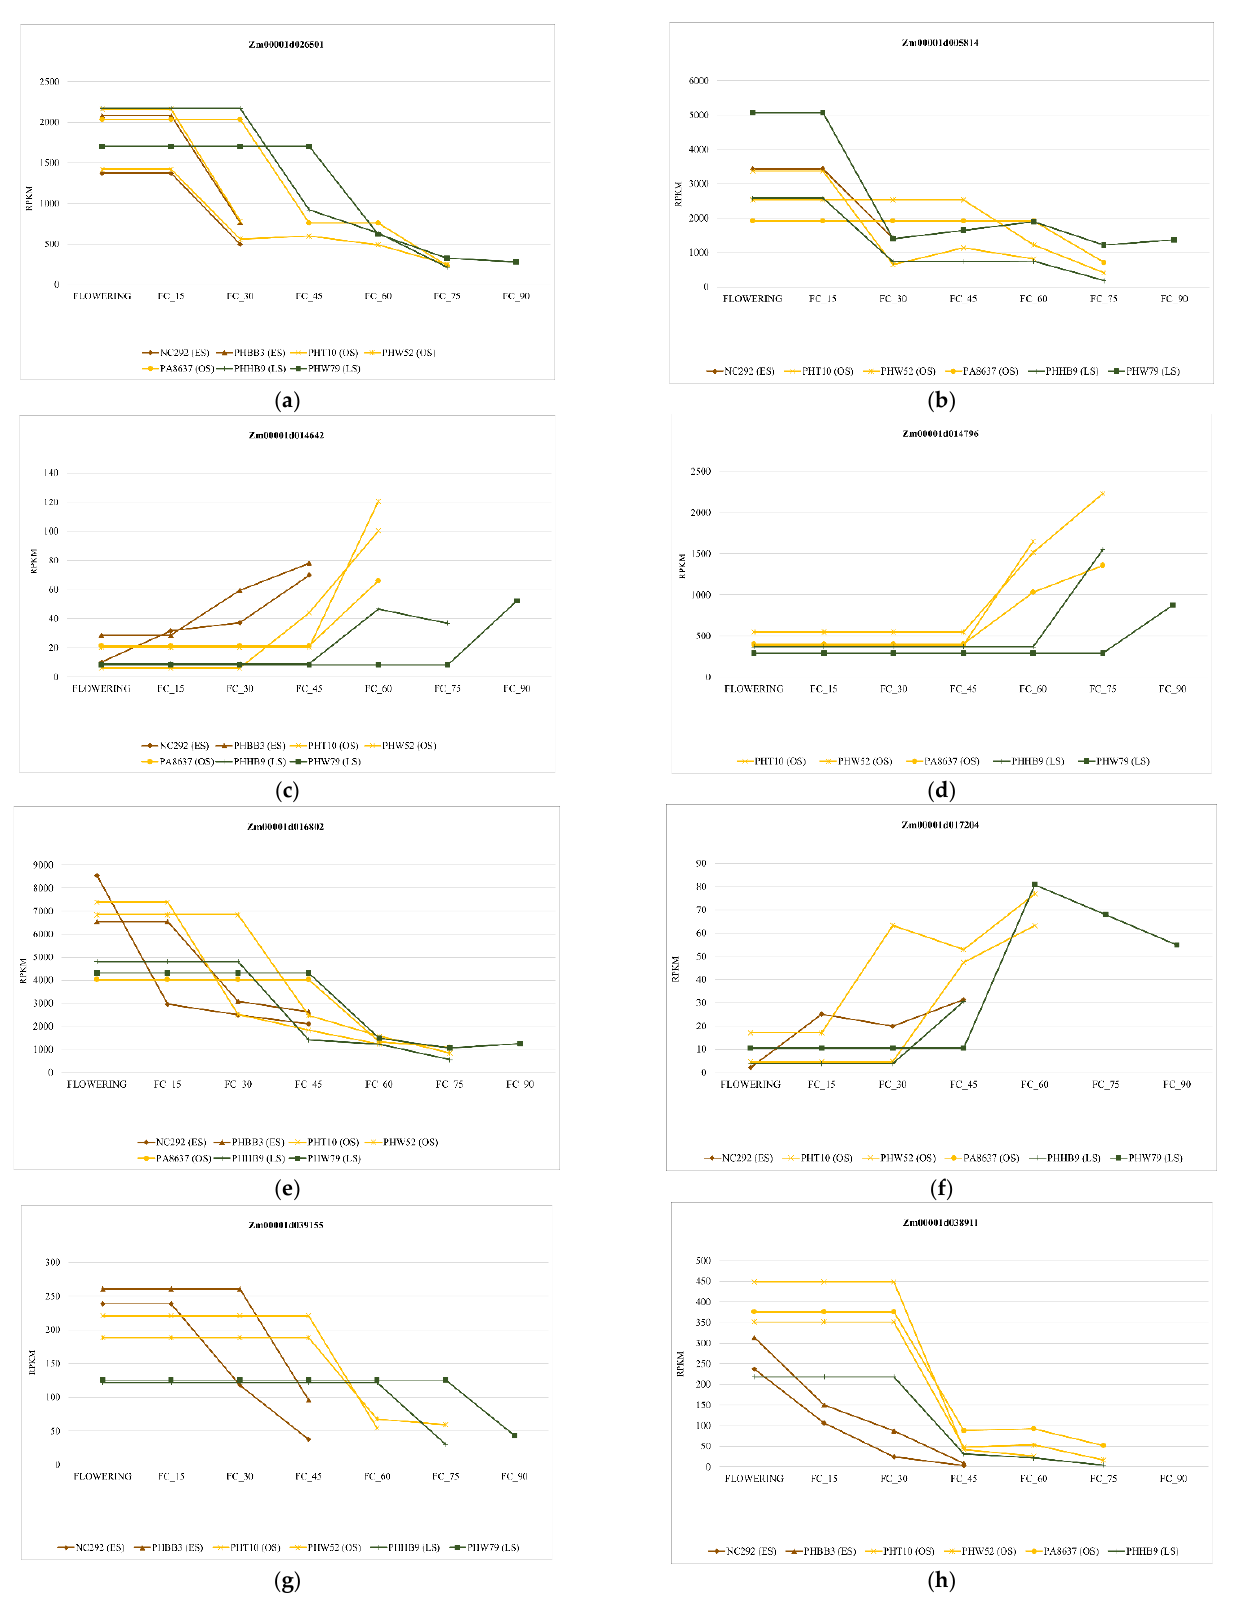
Figure 5. Gene expression levels during senescence, data from [20]. FC_15 — RNA-seq performed 15 days after flowering (RPKM — reads per kilobase million); FC_30 — RNA-seq performed 30 days af- ter flowering (RPKM — reads per kilobase million); FC_45 — RNA-seq performed 45 days after flow- ering (RPKM — reads per kilobase million); FC_60 — RNA-seq performed 60 days after flowering (RPKM — reads per kilobase million); FC_75 — RNA-seq performed 75 days after flowering